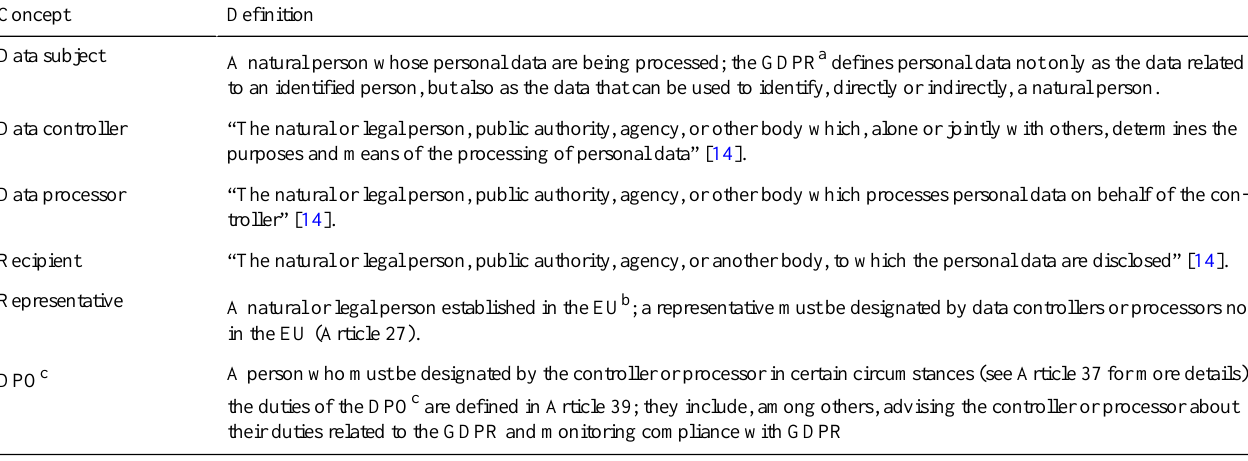
Table 1. Definition of General Data Protection Regulation